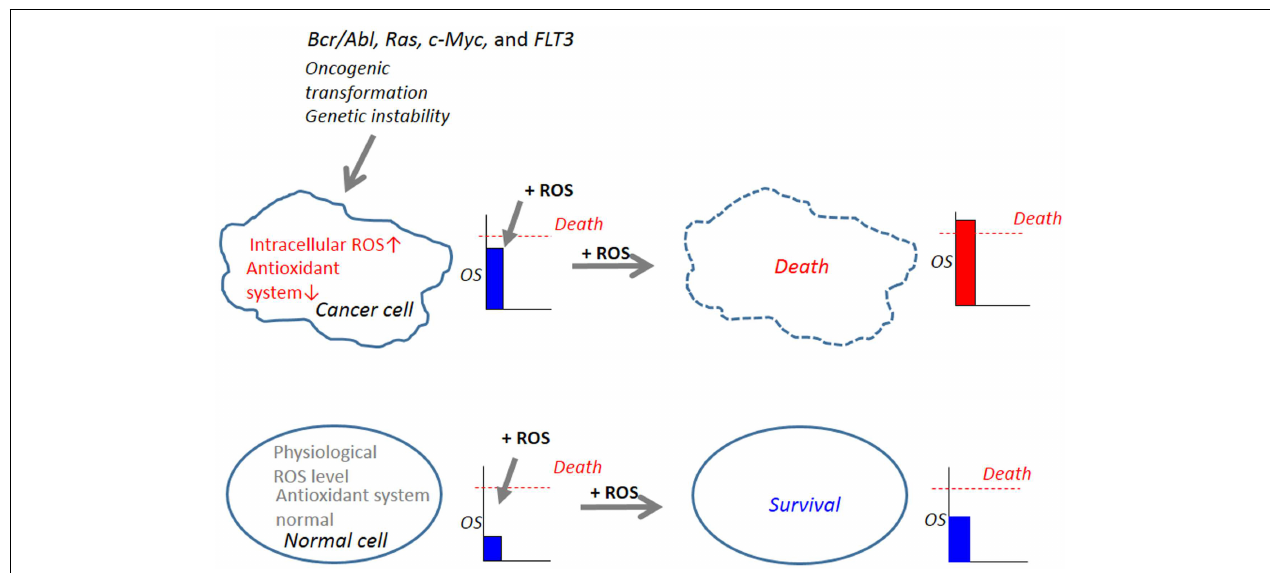
Bcr/Abl , Ras , c-Myc , and FLT3 , which causes increased ROS generation and decreased antioxidant systems, cancer cells harbor an excess OS over normal cells.When equivalent levels of OS are added by the administration of exogenous ROS-inducing agents ( + ROS), OS levels in cancer cells can readily over the threshold of cell death, while OS levels in normal cells do not. Hence, cancer cells are expected to be more vulnerable than normal cells to cell damage induced by ROS-generating agents and this vulnerability can be exploited to selectively kill these